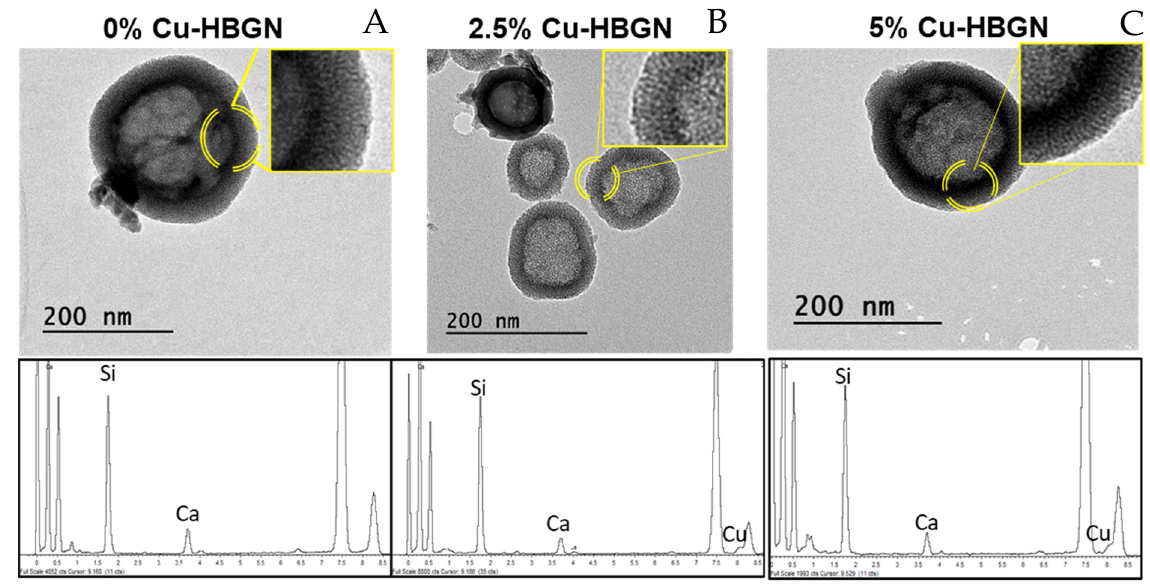
Figure 1. TEM micrographs and the corresponding EDS spectra of 0 ( A ), 2.5 ( B ) and 5% Cu-HBGN ( C ). A magnification of the shell-core zone shows pores with two different morphologies, consequences of the two surfactants used in the synthesis.